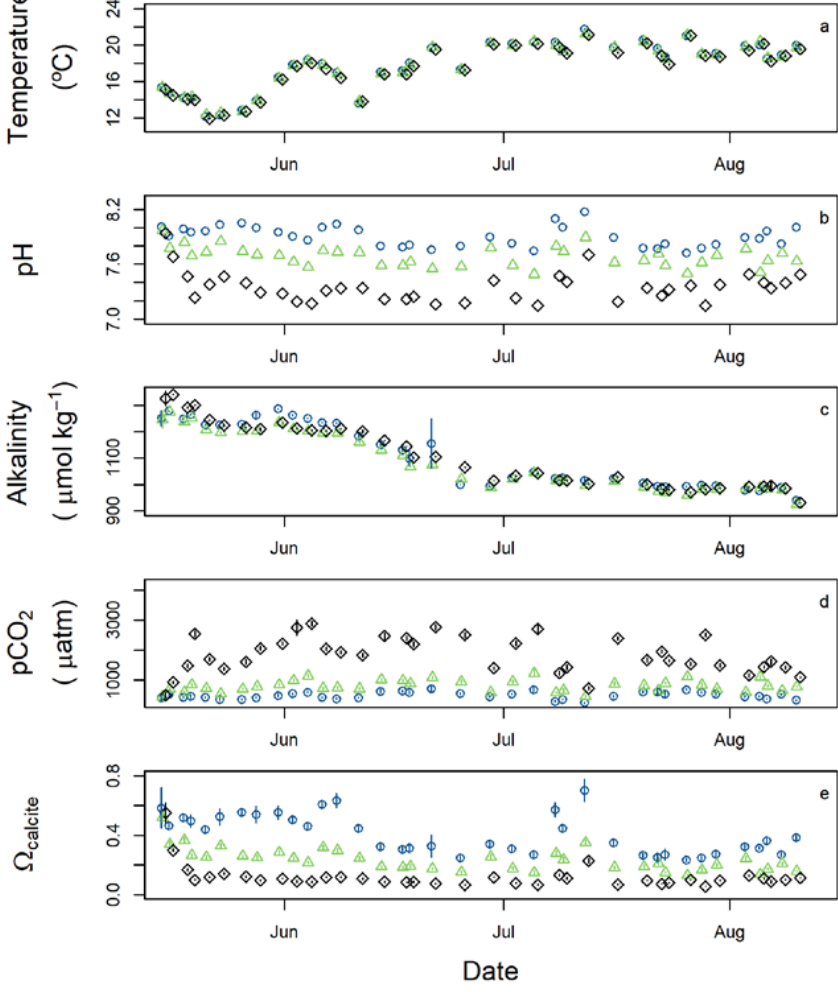
Figure 3. Average daily conditions within the experimental replicate tanks throughout the duration of the experiment. Blue circles indicate the low pCO 2 treatment, green triangles indicate the intermediate pCO 2 treatment, and black diamonds indicate the high pCO 2 treatment. Vertical bars show the standard deviation of all 12 tanks at each pCO 2 treatment. Table 1. Average treatment conditions during the experiment. Measurements are the mean (stand- ard deviation) of 12 tanks per treatment over 35 sampling days.